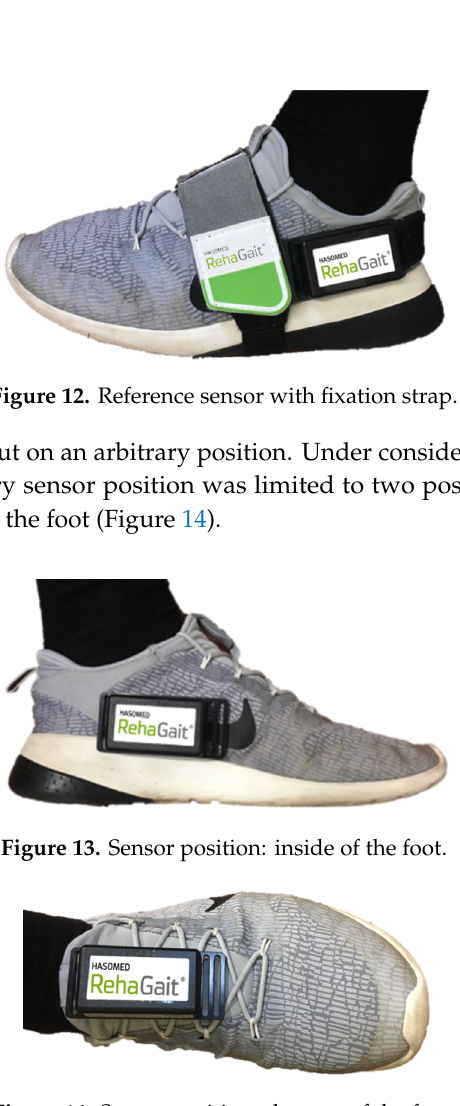
Figure 15. Non-rotated signal and rotated signal of the (cid:1877)⃗ (cid:3028)(cid:3051)(cid:3036)(cid:3046) . Position of the sensor: inside of the foot.